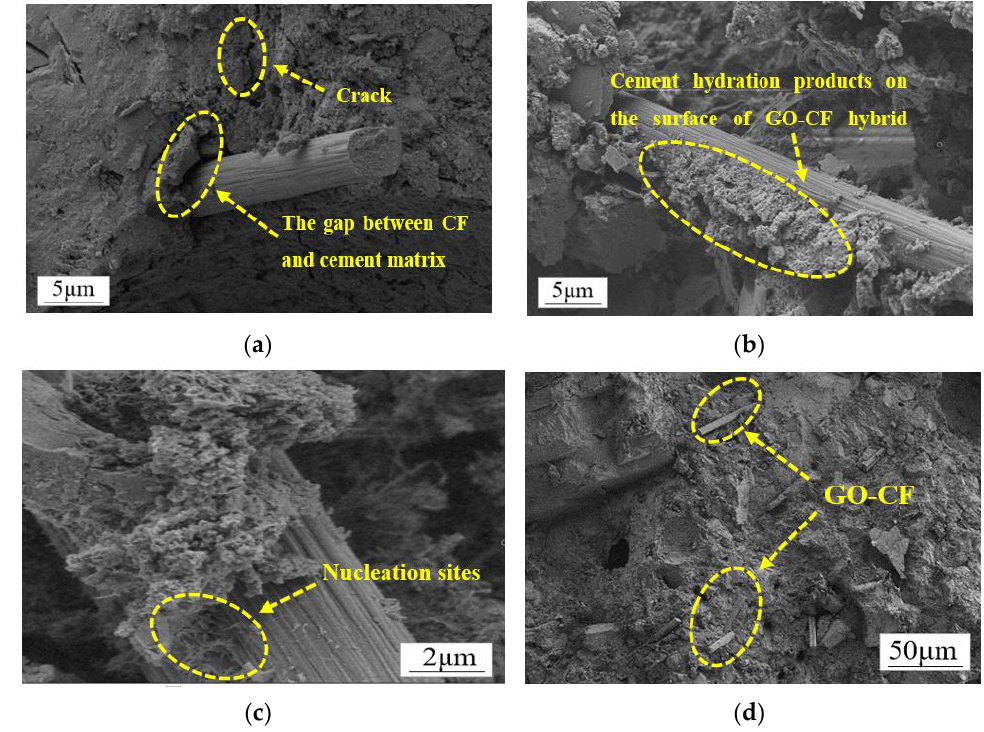
Figure 14. SEM morphology of CF/GO-CF cement matrix composites. ( a ) Interfacial microstructures of CF-Cement, ( b ) interfacial microstructures of GO-CF Cement, ( c ) interfacial microstructures of GO-CF Cement and ( d ) dispersion of GO-CF in cement matrix.